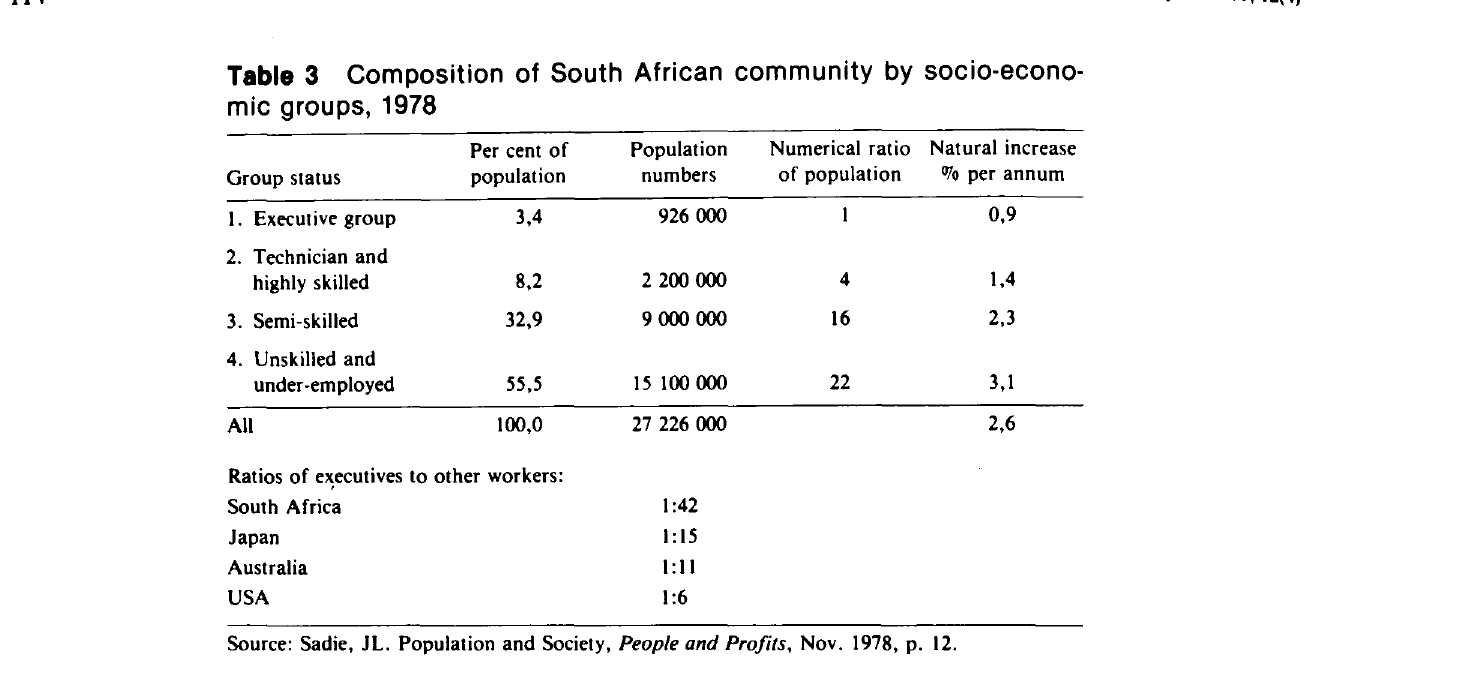
Composition of South African community by socio-econo